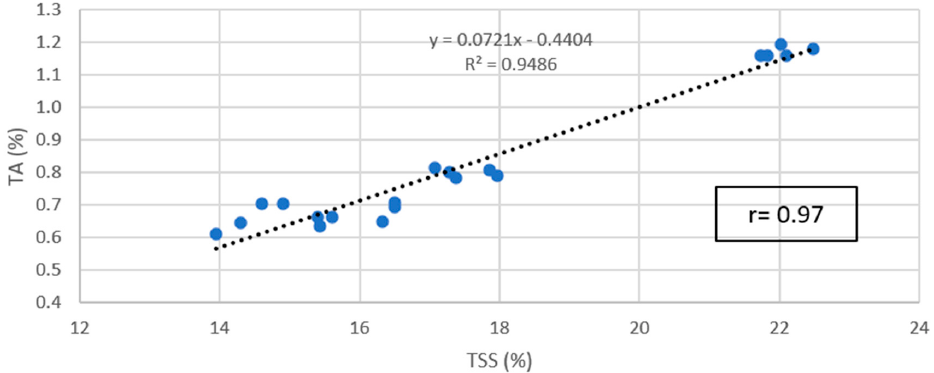
Figure 8. Correlation between total soluble solids (TSS) and titratable acidity (TA) of ‘Regina’ sweet cherry fruit in 2009–2012 regardless of treatment.